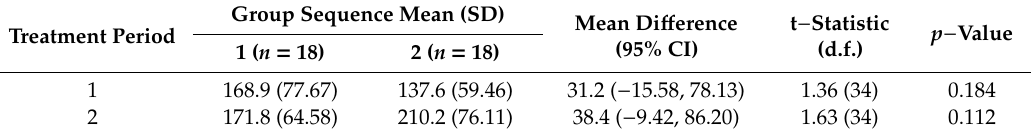
Table 3. Comparison of timeliness in reporting between groups according to treatment period.